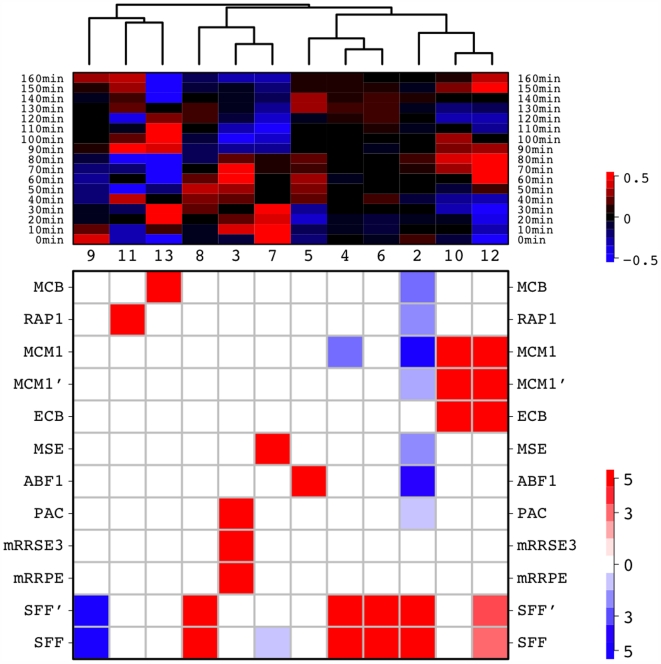
RC diagram of the cell cycle data by Cho et al. using motifs as predictors.Each column is an RC with the original cluster numbers designated by PAM indicated in the middle. Note cluster 1, which contains 599 genes, is designated as a null cluster and not shown. The top section of the graph shows the average expression profile of the genes in a specific RC, which is clustered based on Pearson correlation and average linkage. The magnitude of the expression in log2-ratios can be read off from the color bar at the top right hand side. The bottom section depicts signature motifs in the corresponding RC. The color red indicates enrichment  by a Chi-square test of association; the color blue corresponds to the depletion . The color bar at the lower right hand side is in  scale and the color signals the direction of the test.